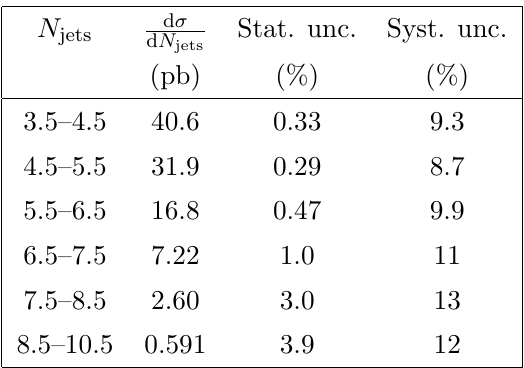
Table 11 . Results of the absolute di(cid:11)erential cross sections with relative uncertainties in the combined channel with respect to N jets .